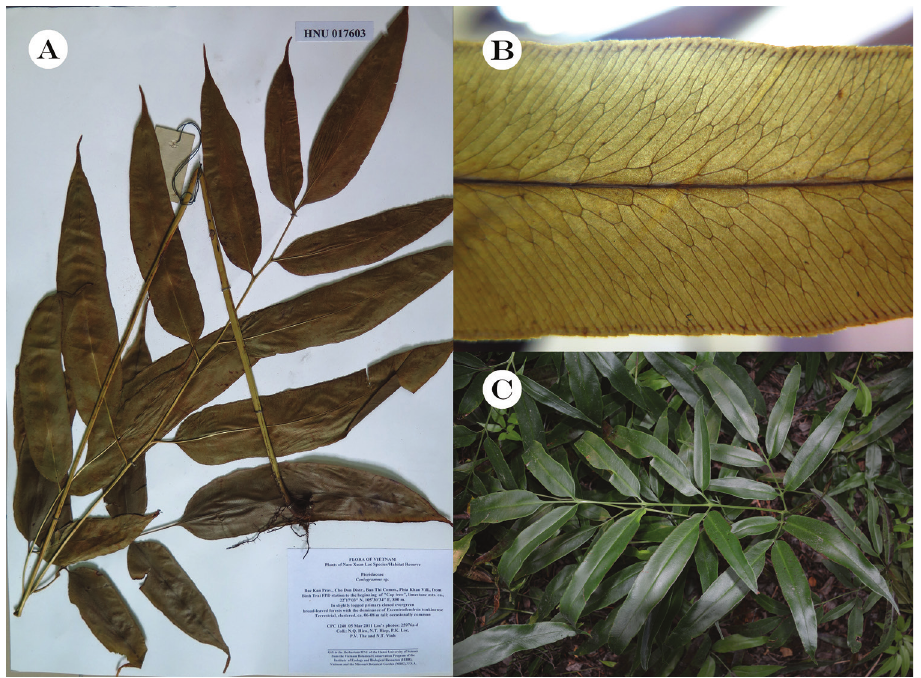
Figure 1. Coniogramme japonica (Thunberg) Diels A one of the voucher specimens B portion of a pin- nule, showing anastomosing veins C morphology and